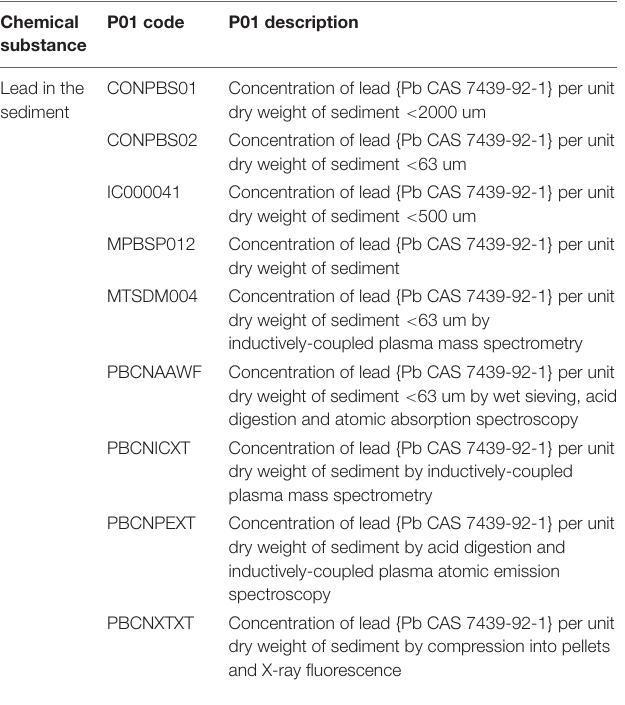
TABLE 1 | Example of P01 codes representing Lead concentration in the sediment, present in ADRION Regional Data Collection. Chemical P01 substance